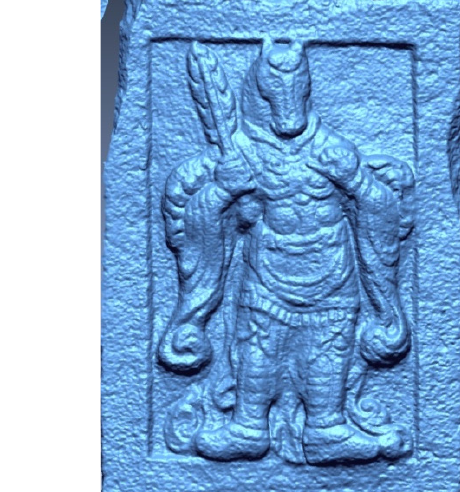
axis for reasons that the authors are still